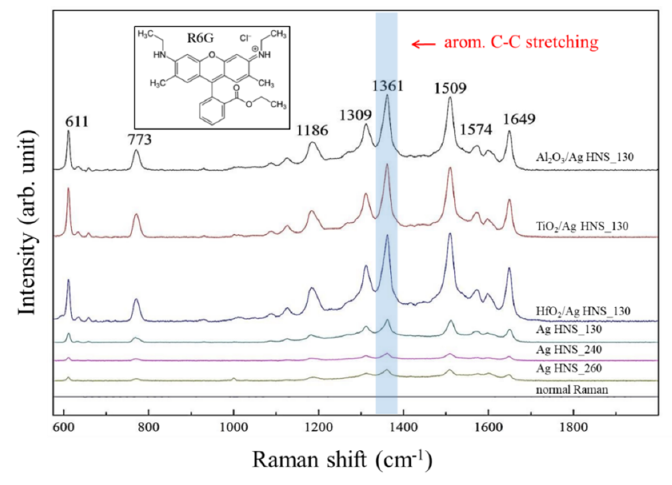
Figure 4. SERS spectra of R6G, as a probe molecule, upon Ag HNS, Al 2 O 3 /, HfO 2 /, and TiO 2 /Ag HNS.